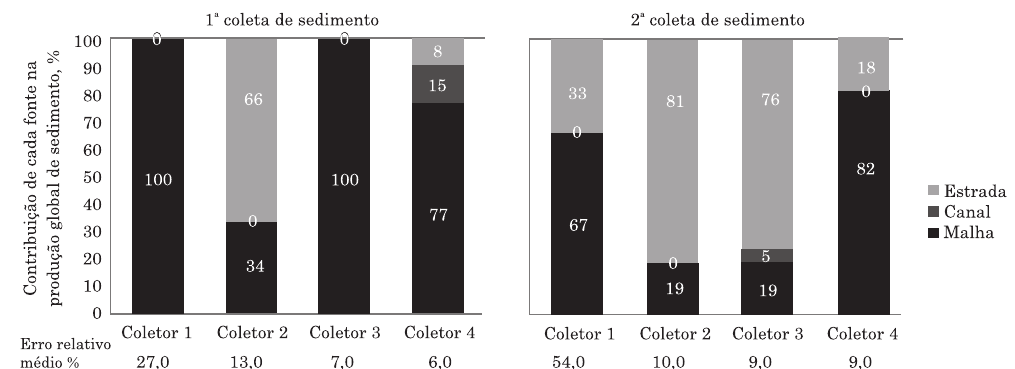
Figura 2. Contribuição relativa das áreas de estrada, canal e malha de amostragem na produção de sedimentos na bacia hidrográfica do rio Vacacaí-Mirim, Santa Maria, RS, para a primeira e segunda coleta de sedimento em